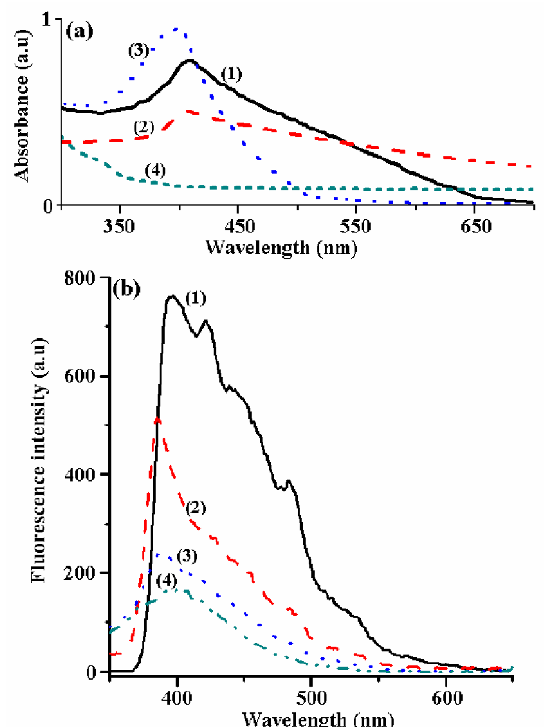
Figure 10. The UV (a) and fluorescence (b) spectra of raw ZnO nanoparticles (1), ZnO-BEI (2), ZnO-PCEMA-Br-2 (3) and ZnO-PCEMA- b -PEGMA-Br-2 (4) block copolymer ( λ =340 exc